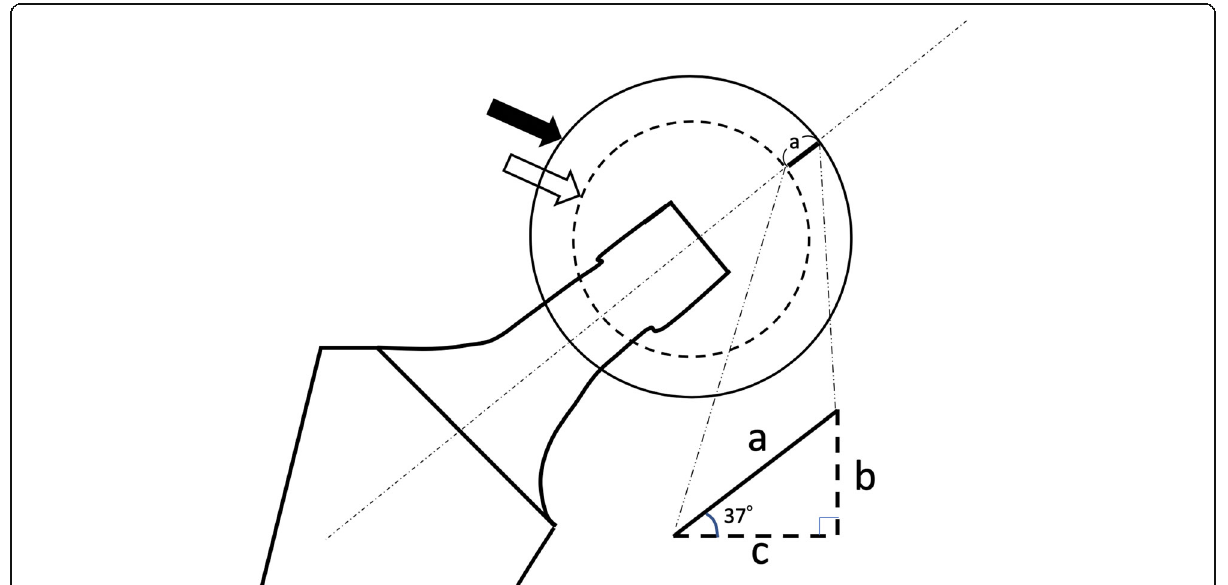
Fig. 2 Image of extended length between 32 mm trial head and mobile polyethylene liner used in dual mobility system. Black arrow indicates mobile polyethylene liner, and white arrow indicates 32 mm trial head. We used stem angle only 127°, extended length along to body axis ( b ) is calculated by extended length along to neck axis ( a ) multiplying sin 37°. Extended length along to offset axis ( c ) is calculated by extended length along to neck axis ( a ) multiplying cos 37